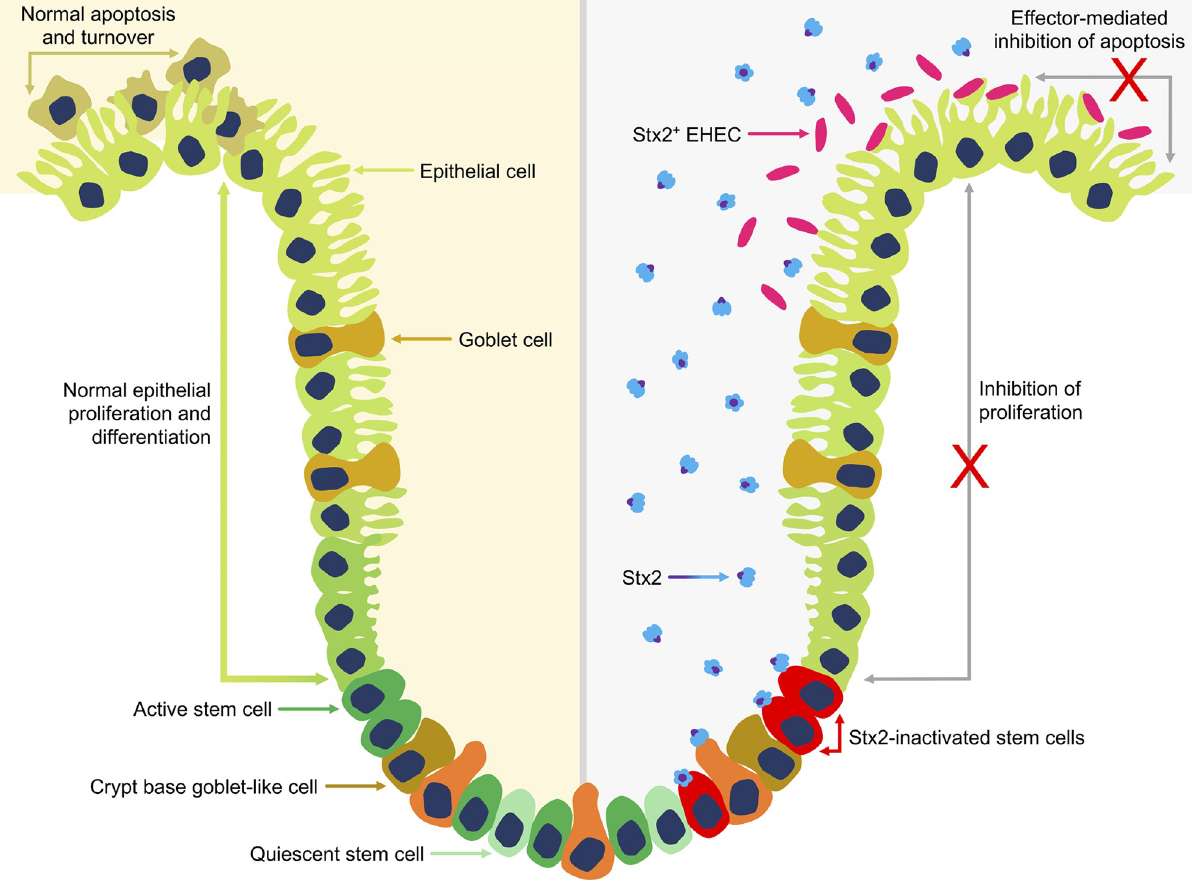
Fig 6. Stx2 mediated inhibition of bovine intestinal epithelial proliferation. Normal intestinal epithelial proliferation and differentiation (left) is driven by active stem cells located at the base of crypts. Stem cells continuously generate proliferating progeny that differentiate into the various cell lineages of mature intestinal villi and migrate up the crypt toward the villus tip. Continuous generation of new intestinal epithelial cells is balanced by apoptosis of older cells at the luminal surface resulting in the rapid turnover of intestinal epithelial cells. Expression and release of Stx2 into the intestinal crypt (right) by colonising Stx2+ EHEC O157 is proposed to inhibit normal stem cell driven proliferation. Inhibition may be direct by Stx2 binding to and inactivating Gb3+ stem cells or indirect inhibition of stem cells by interaction of Stx2 with as yet unidentified Gb3+ cells in the base of the crypt. E . coli O157 colonises at the luminal surface and further inhibits local epithelial turnover by type 3 secretion system-mediated delivery of specific effectors that can inhibit apoptosis.